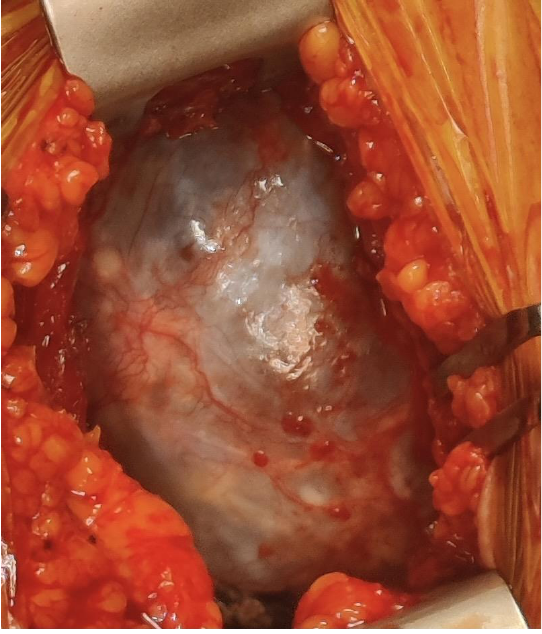
Figure 3. Large cyst can be seen after doing leftposterolateral